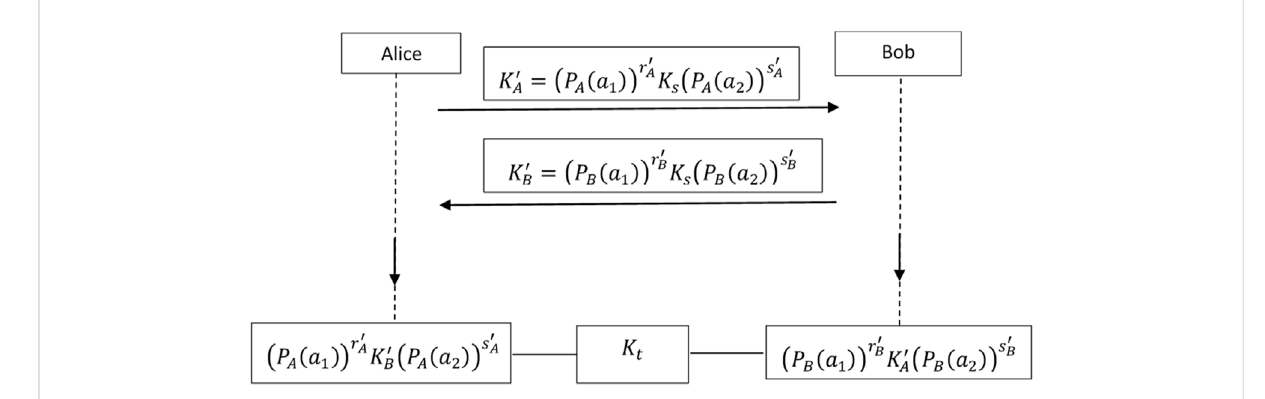
the Stickel scheme and the key exchange